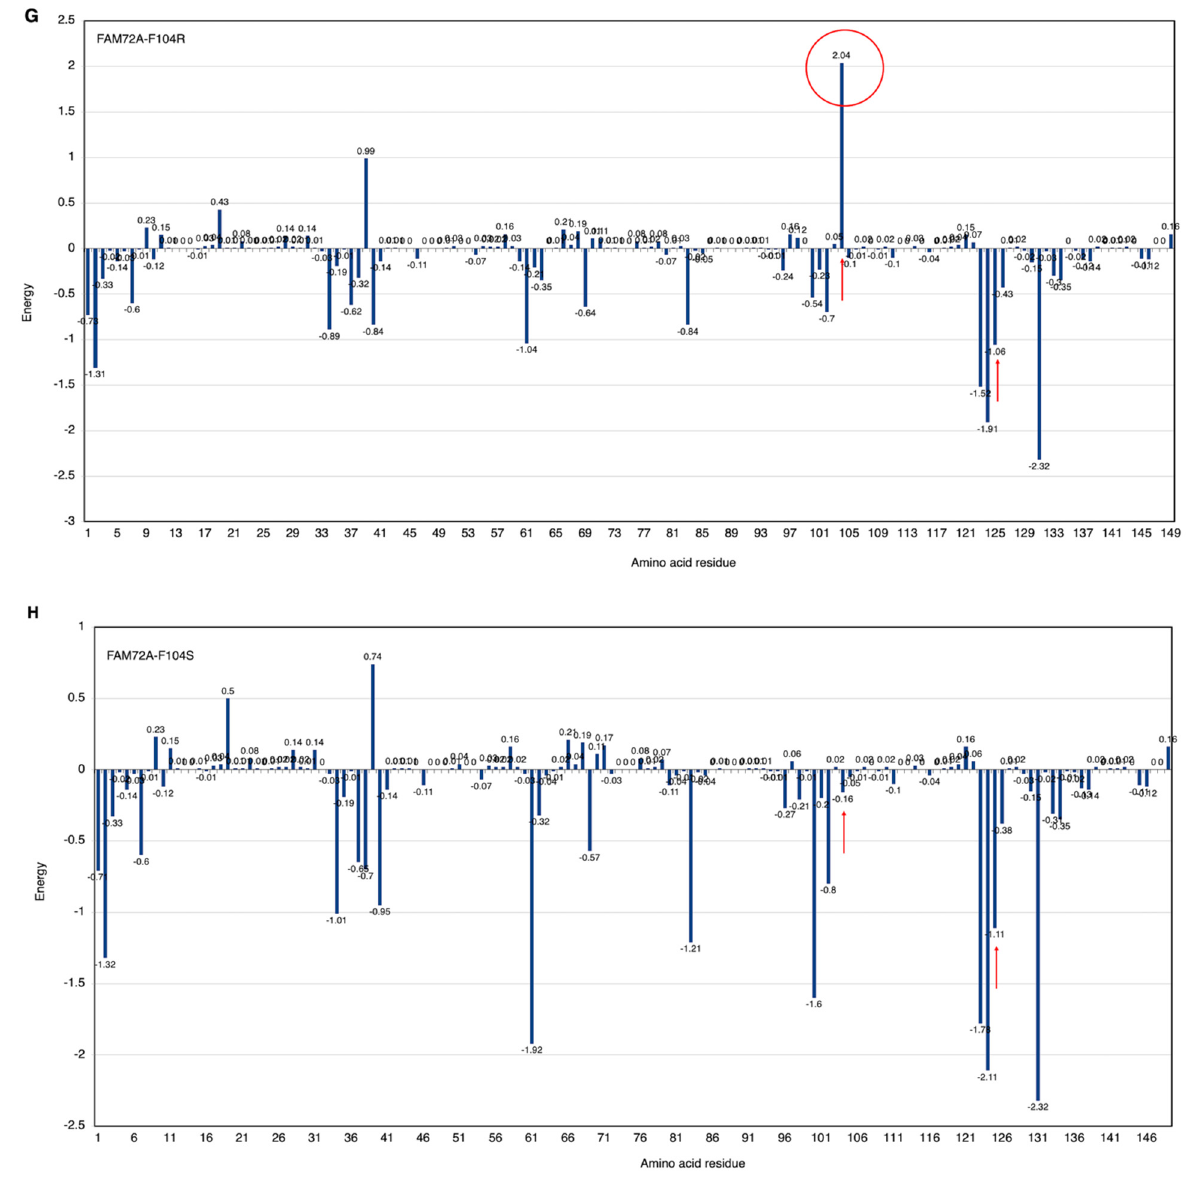
Figure 6. ( A – H ) FWMF motif (AA 101–104)-specific mutation-dependent FAM72A protein and UNG2 (AA 1–45) peptide heterodimer free binding energy. FAM72A mutations at AA F104 phenylalanine (F104 → F104A, F104R, F104N, F104G, and F104S). The essential AA residues in FAM72A-wt and UNG2 interaction are the 2, 37–40, 61, 83, 104, 123–126, and 131 AAs of FAM72A. The highest binding energy (kcal/mol) goes to FAM72A’s AA F104 within the FWMF motif (AA 101–104). Positive values indicate low binding energies and weak interactions, whereas more negative values indicate stronger interactions. Values around 0 indicate moderate interactions between FAM72A and UNG2. A change in the FWMF motif from wt F104 to F104R shows the largest effect, turning the binding energy from negative ( − 2.7; strong binding/hydrophobic core) to positive (+2.04; strong binding/hydrogen bonding).